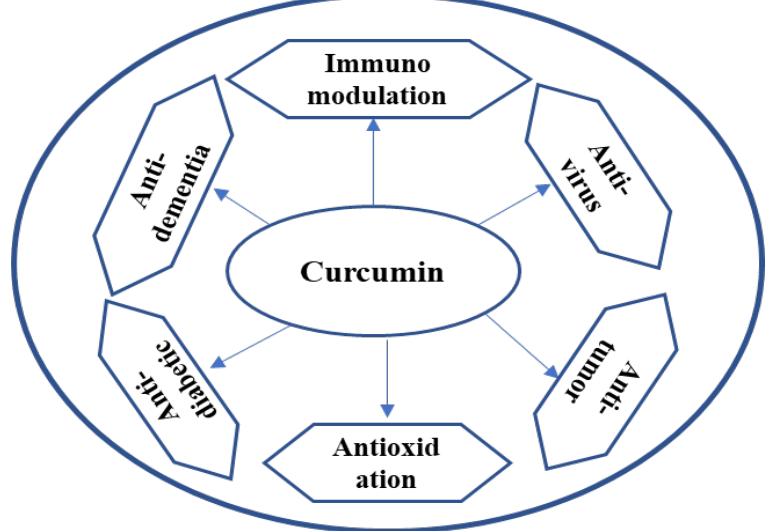
Figure 9. Curcumin main phytochemical of